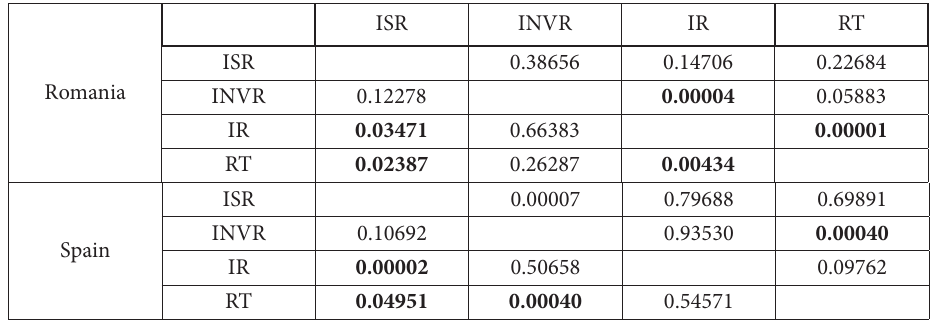
Table 4. Granger causality